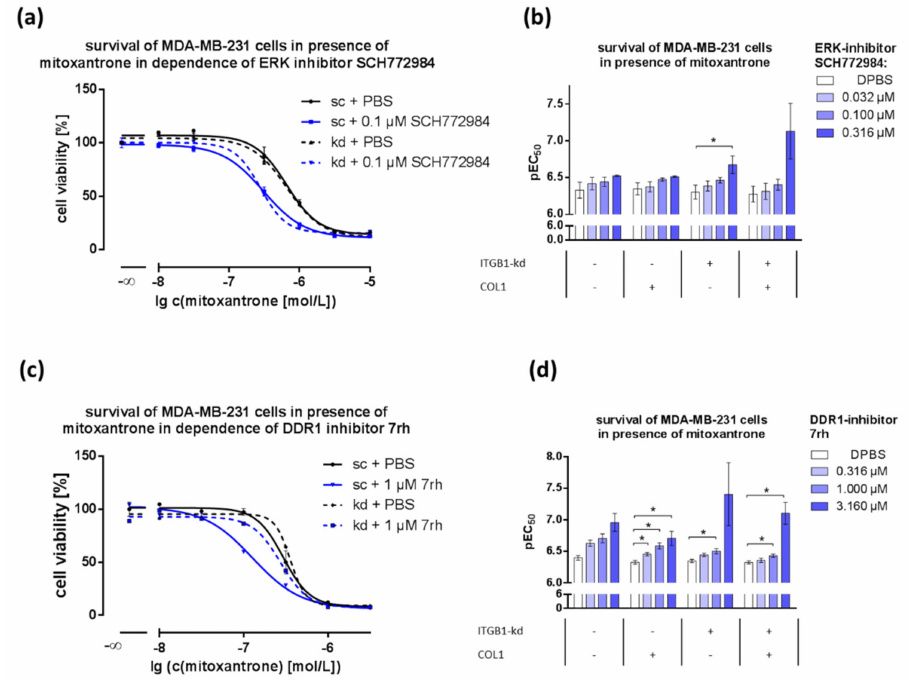
Figure 5. The impact of DDR1- or MAPK-inhibitors on the survival of MDA-MB-231 and MCF-7 cells with mitoxantrone in combinatorial approaches. The ERK1 / 2-inhibitor SCH772984 ( a , b )